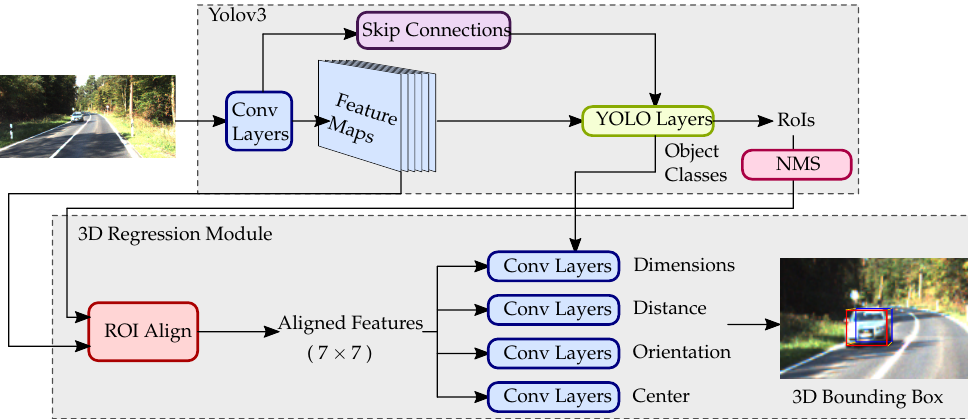
Figure 1. Illustration of our 3D bounding box detector. A single RGB image is used as the input for our method; the shared convolutional features are then extracted by the network backbone, Darknet-53. We leverage the proven 2D object detector, YOLOv3, to perform the RoI and object class prediction. We then extract the RoI features by using the feature alignment used in [14]. The 3D bounding box parameters are predicted by our CNN’s parameter prediction, and finally the 3D bounding box is drawn on the